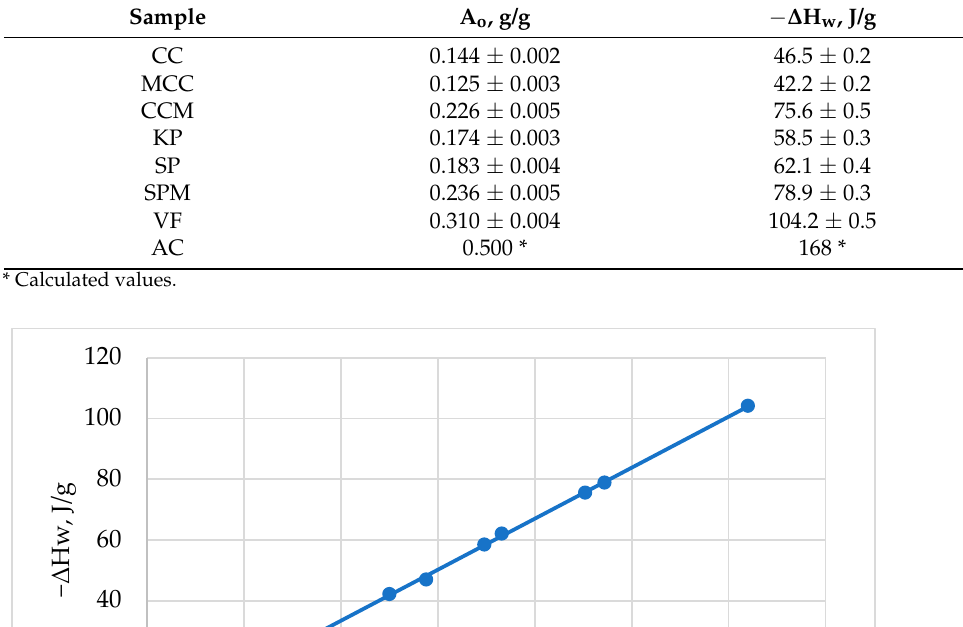
Figure 4. Linear form of sorption isotherms for samples of MCC (1), CC (2), SP (3), SPM (4), VF (5), and AC (6). Table 2. Maximum moisture absorption and wetting enthalpy for cellulose samples.